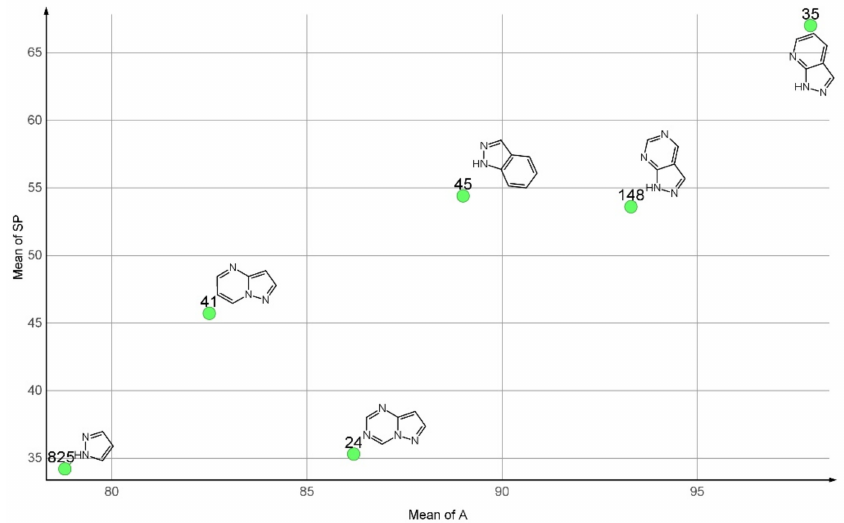
Figure 4. Most frequent pyrazole based PRs with the number of compounds containing them and the average values of their SP and A